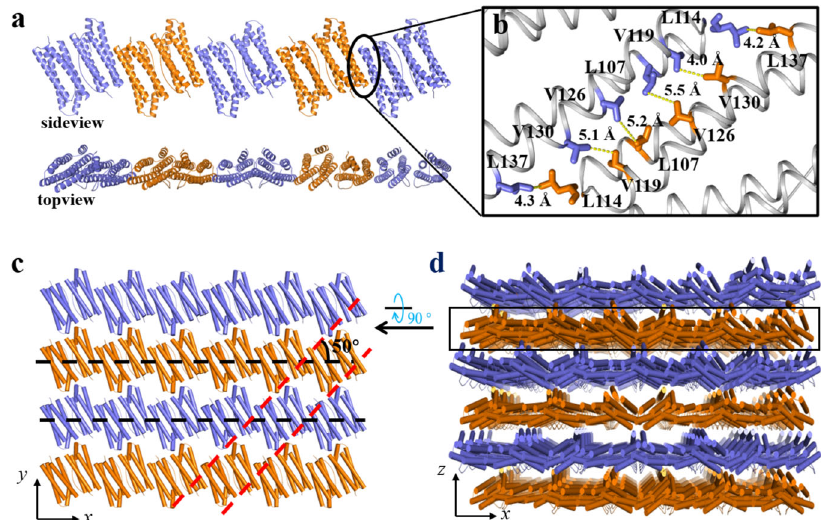
Fig. 7 The crystal structure and arrangement of FLAL-L mutant. a Side and top views of the 1D FLAL-L fi lament in the crystal structure. b Close-up view of the hydrophobic interactions between two adjacent FLAL-L molecules. c The 1D fi laments coalesce in parallel along the y axes to form 2D protein layer, corresponding to the 2D ribbons observed by TEM. The dashed lines in c correspond to the lines shown in Fig. 6i. d From the top view, FLAL-L molecules assemble into 3D protein